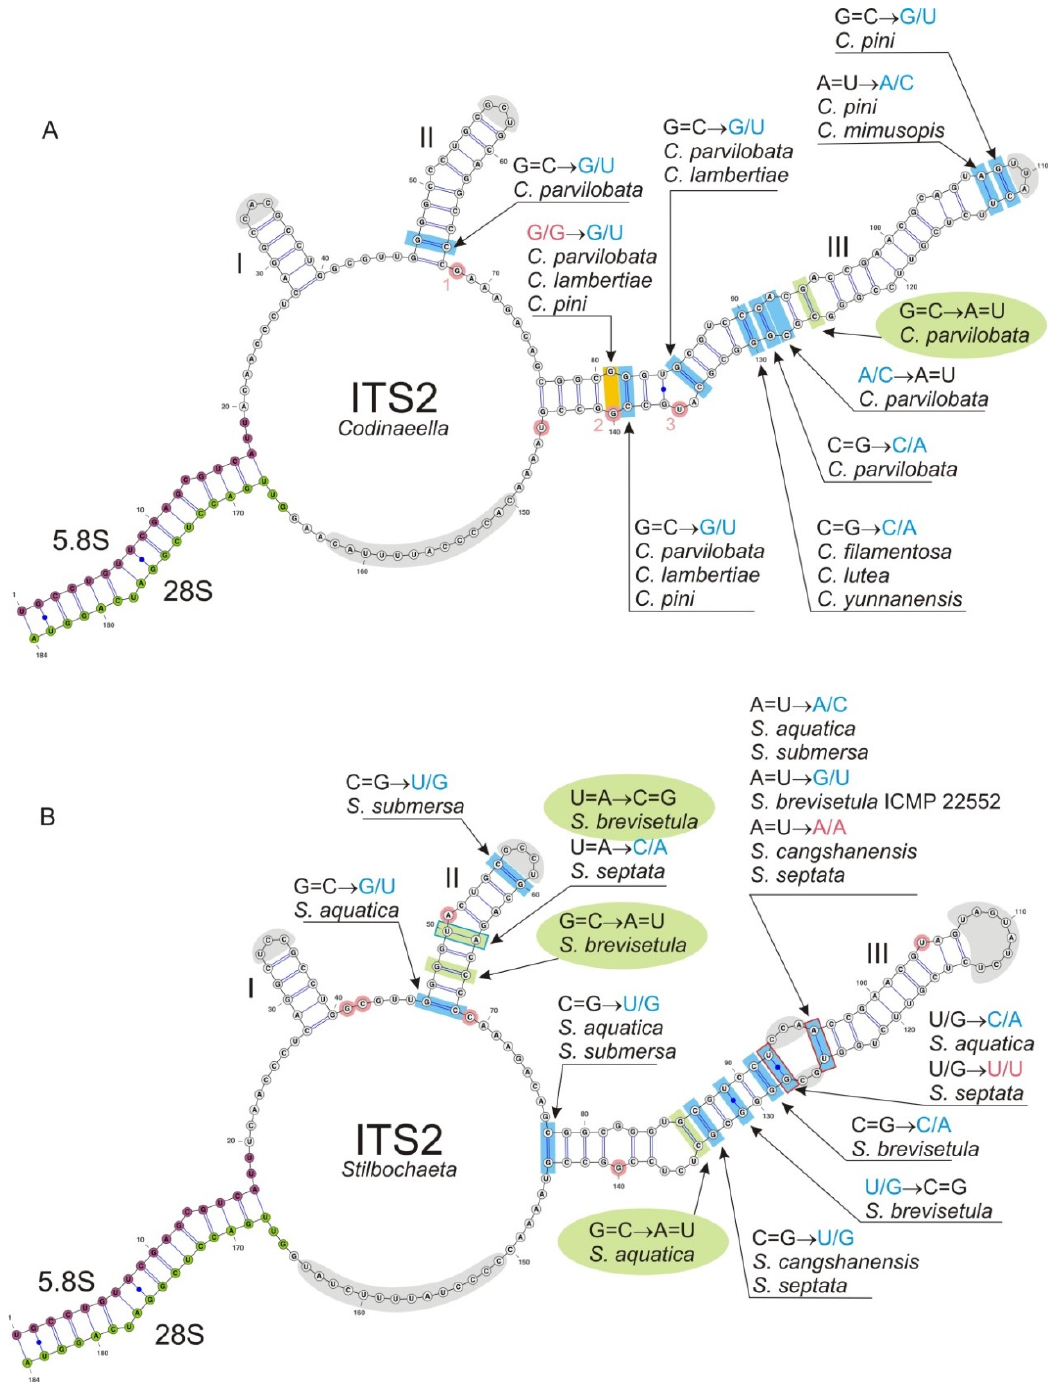
Figure 5. ITS2 secondary structure of Codinaeella and Stilbochaeta and 5.8S-28S rRNA gene hybridization (proximal stem region). ( A ) Codinaeella minuta CBS 146620 (GenBank accessions ITS: OL654095, 28S: OL654152) ( B ) Stilbochaeta malaysiana IMI 312436 (GenBank accessions ITS: OL654121, 28S: OL654178). Details as in Figure 4.